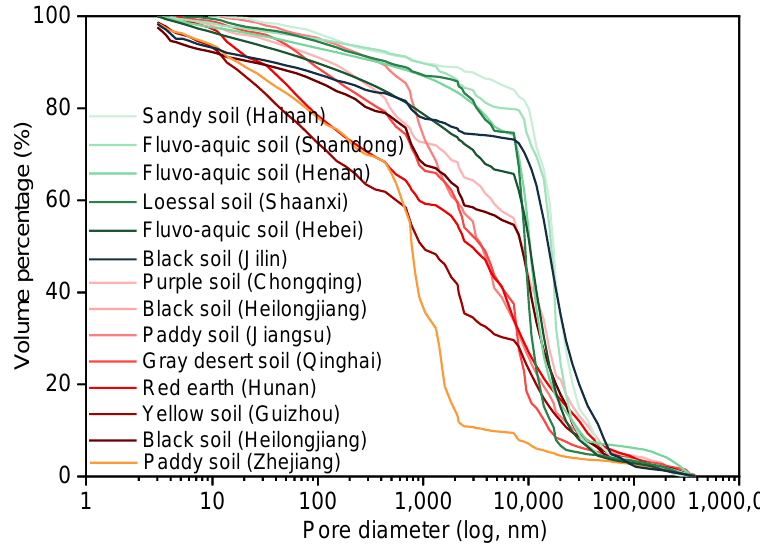
Figure 1. Soil pore size distribution curves of fourteen types of soils. With the leakage of 10 mL diesel on fourteen types of soil surfaces, the migration process of diesel front was fast initially and then slowed down to reach a steady state in the soil (Figure 2). The migration rate of diesel before 0.5 h was about 1 cm/h, then gradually trended to 0. The previous study reported that NAPLs are strongly driven by gravity at the initial stage of leakage [37]. Compared with the migration distance of diesel in fourteen types of soils, the migration process of diesel could be divided into three categories (I: 3.0 cm < S < 5.0 cm, II: 5.0 cm < S < 7.0 cm, III: S > 8.0 cm). For example, the migration distance of diesel in seven types of soils including gray desert soil (Qinghai), yellow soil (Guizhou), red earth (Jiangxi and Hunan), paddy soil (Zhejiang and Jiangsu), and purple soil (Chongqing) ranged 3.0 cm to 5.0 cm.